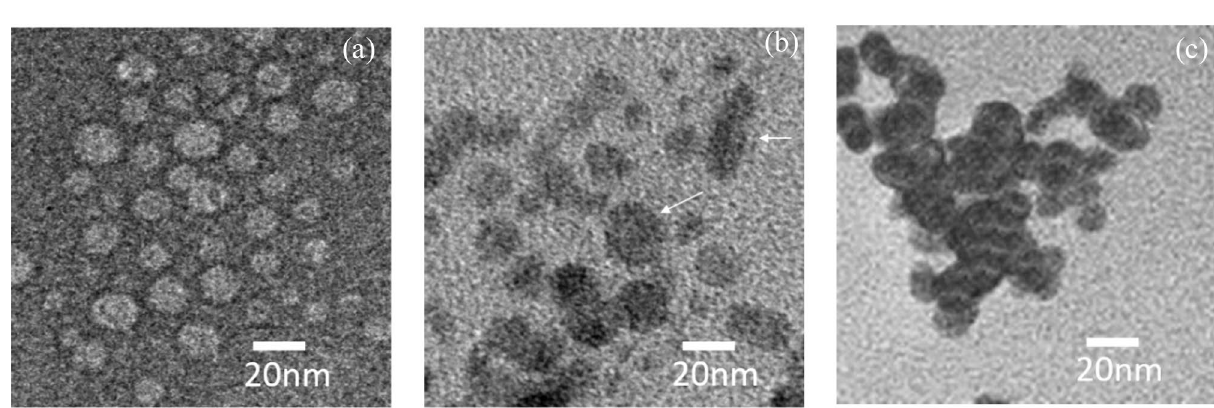
Figure 3. FE-TEM images of ( a ) QDs/SA, ( b ) QDs/SA-Ab, ( c )